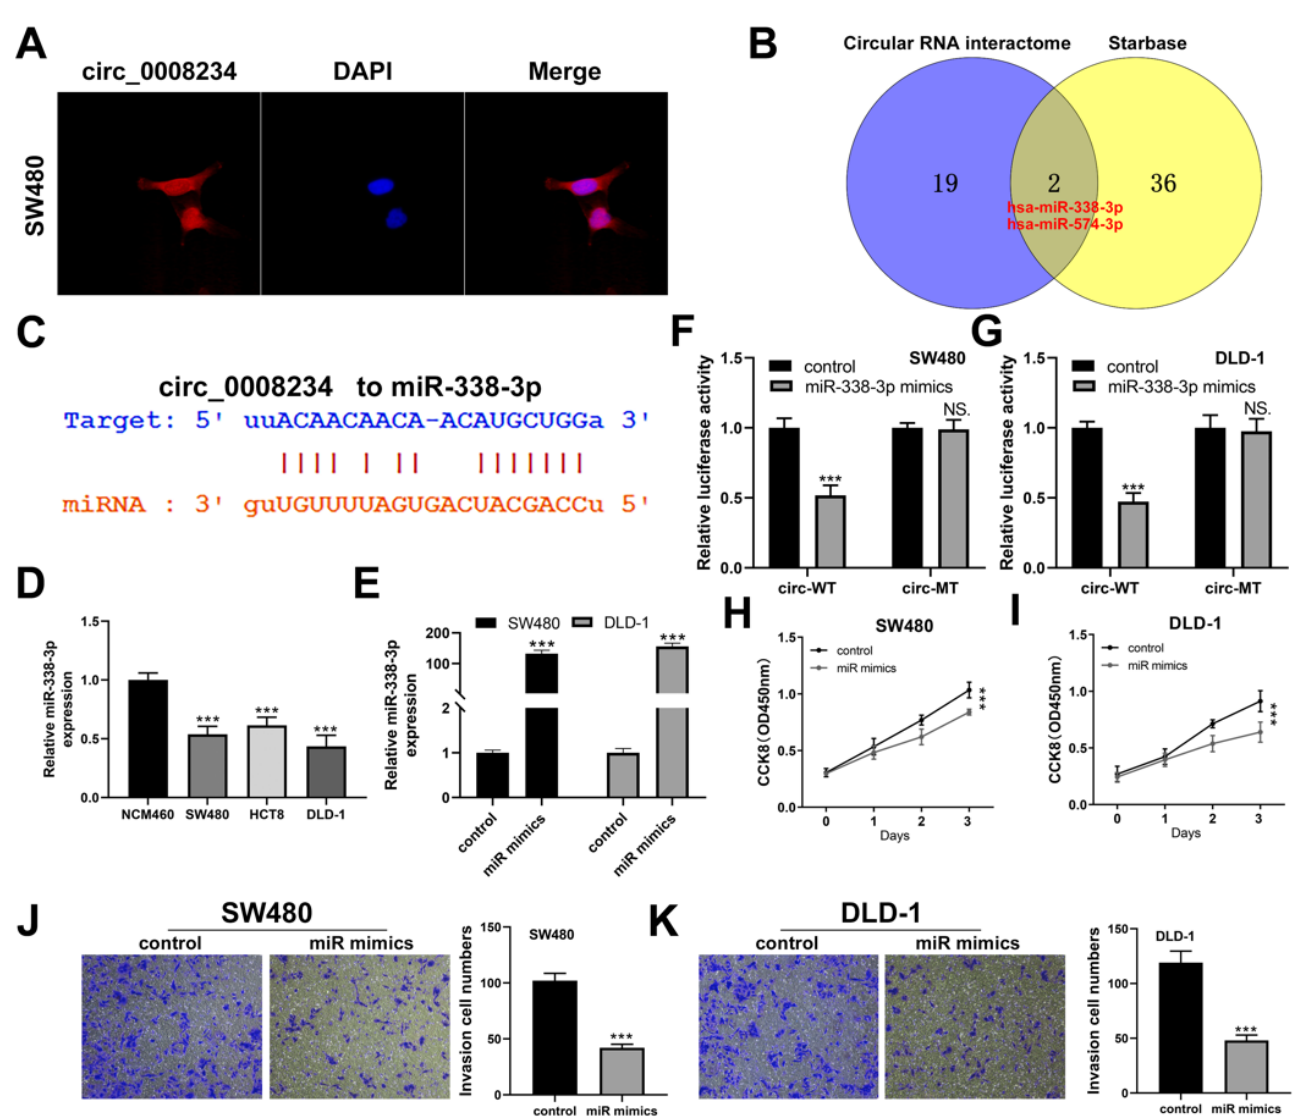
Figure 4. Hsa_circ_0008234 acts as a “molecular sponge” for miR-338-3p. Notes: ( A ) FISH assay of hsa_circ_0008234 in SW480 cell line; ( B ) Circular RNA interactome and Starbase identified two miR-338-3p and miR-574-3p that might be bound with hsa_circ_0008234; ( C ) The docking site of miR- 338-3p and hsa_circ_0008234; ( D ) MiR-338-3p was downregulated in colon cancer cells, *** = p < 0.001; ( E ) qRT-PCR was utilized to evaluate the overexpression efficiency of miR-338-3p, *** = p < 0.001; ( F , G ) Luciferase enzyme reporter assay was conducted in the cells harboring wild-type, as well as mut-type of hsa_circ_0008234, NS. = p > 0.05, *** = p < 0.001; ( H , I ) CCK8 testing was done between the miR-338-3p overexpressed and control cells, *** = p < 0.001; and ( J , K ) Transwell testing was done between the miR-338-3p overexpressed and control cells, *** = p < 0.001.